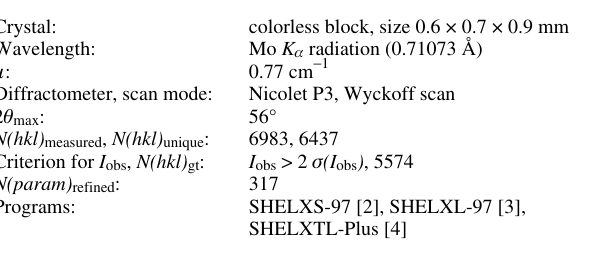
Table 1. Data collection and